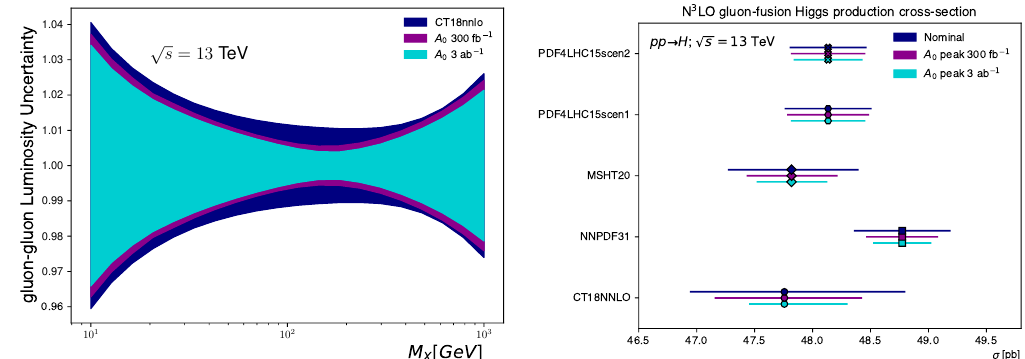
Figure 2: [ Left ] Ratio of PDF uncertainties for the gluon-gluon luminosity evaluated (cid:112) s = 13 TeV. The blue band shows the uncertainties of the CT18NNLO PDF set [ 17 ] , at reduced to 68% CL coverage. The magenta and cyan bands show the impact of including constraints from the A measurement and assuming 300 fb − 1 and 3 ab − 1 , 0 respectively. [ Right ] PDF uncertainties on the N3LO gluon-gluon fusion Higgs boson cross-section, shown for different PDF sets before and after the inclusion of the A measurement